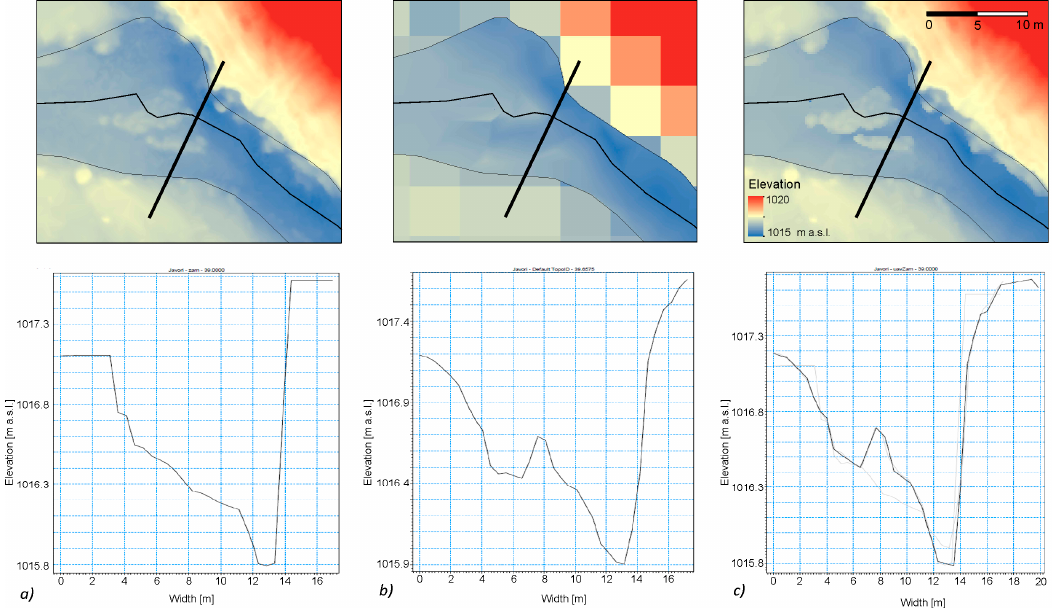
Figure 4. Digital terrain models based on different source data with corresponding cross-section profile. ( a ) Digital surface model (DSM) based on unmanned aerial system (UAS) photogrammetry;